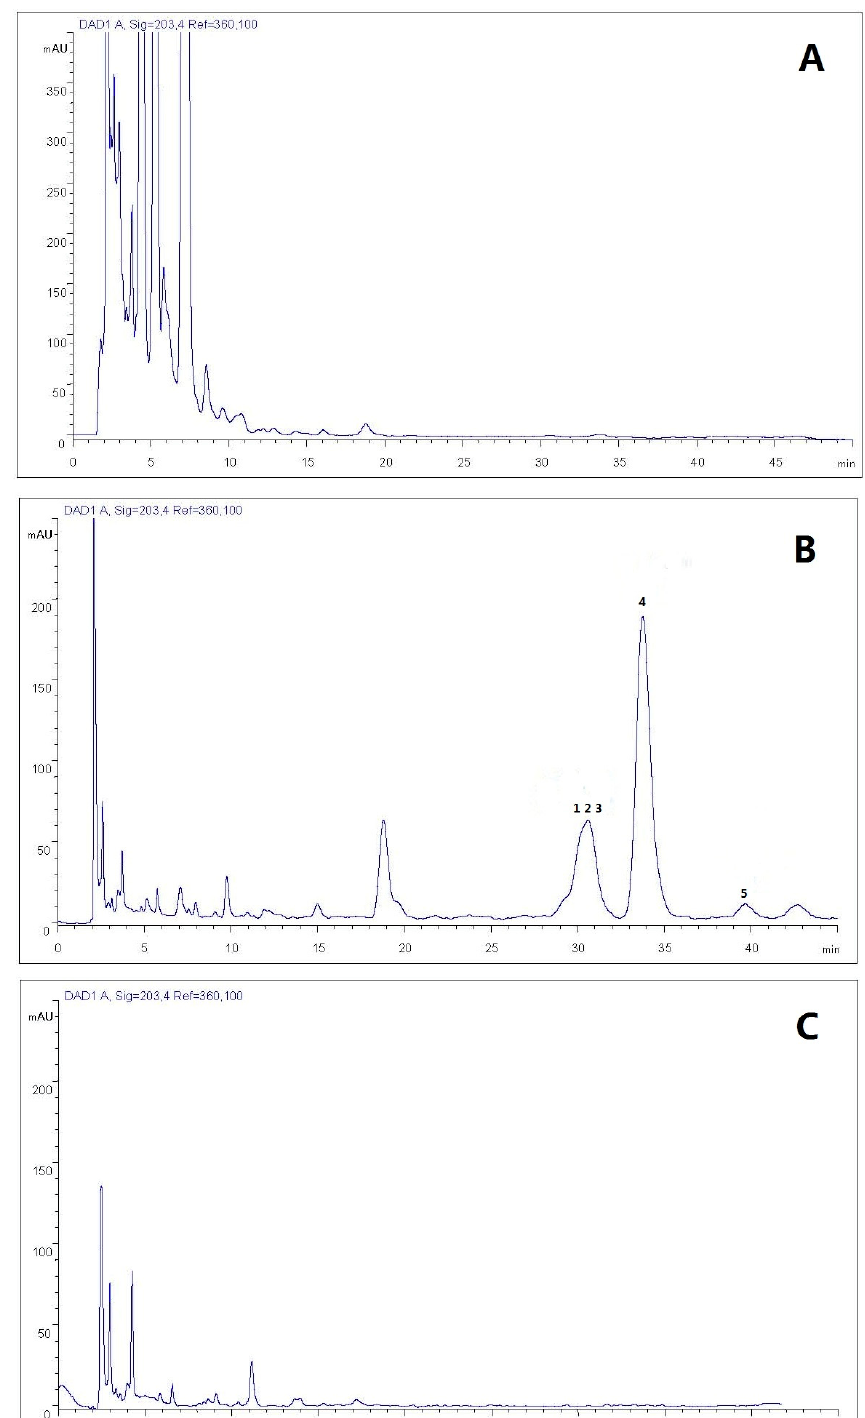
Figure 3. The chromatograms of ginsenoside fractions obtained from solid phase extraction (SPE) with different eluting solvents (methanol/water = 80:20). ( A ) The eluted fraction of 65% aqueous methanol; ( B ) the eluted fraction of 80% aqueous methanol; and ( C ) the eluted fraction of 90% aqueous methanol. Peaks: 1: 20( S )-methoxyl-ginsenoside Rg 3 ; 2: 20( R )-methoxyl-ginsenoside Rg 3 ; 3: ginsenoside Rk 1 ; 4: ginsenoside Rg 5 ; 5: ginsenoside M1.